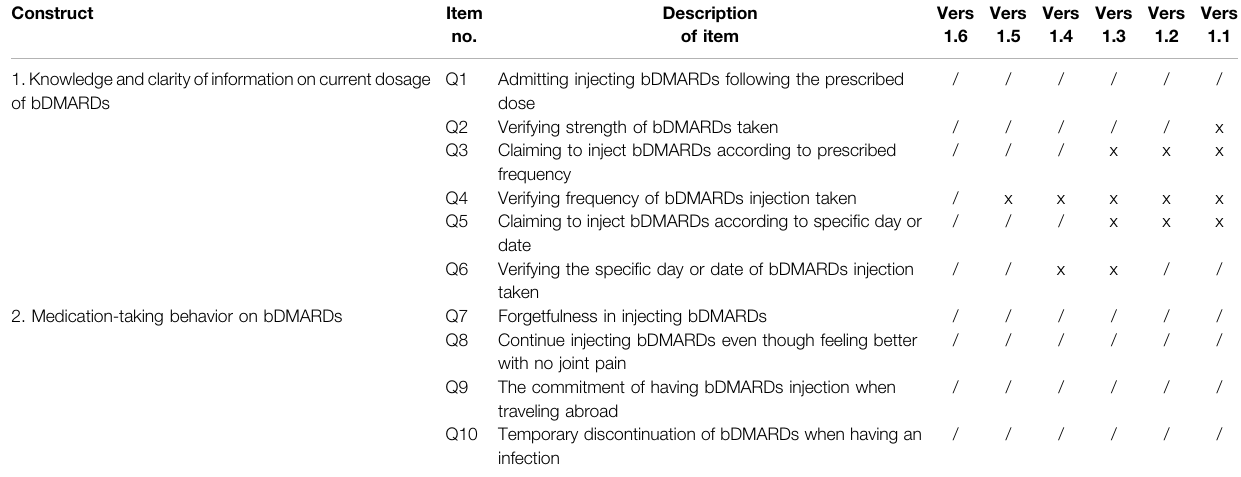
TABLE 1 | Description of items included in the development of SCADS ( fi nal version 1.6). Construct Item